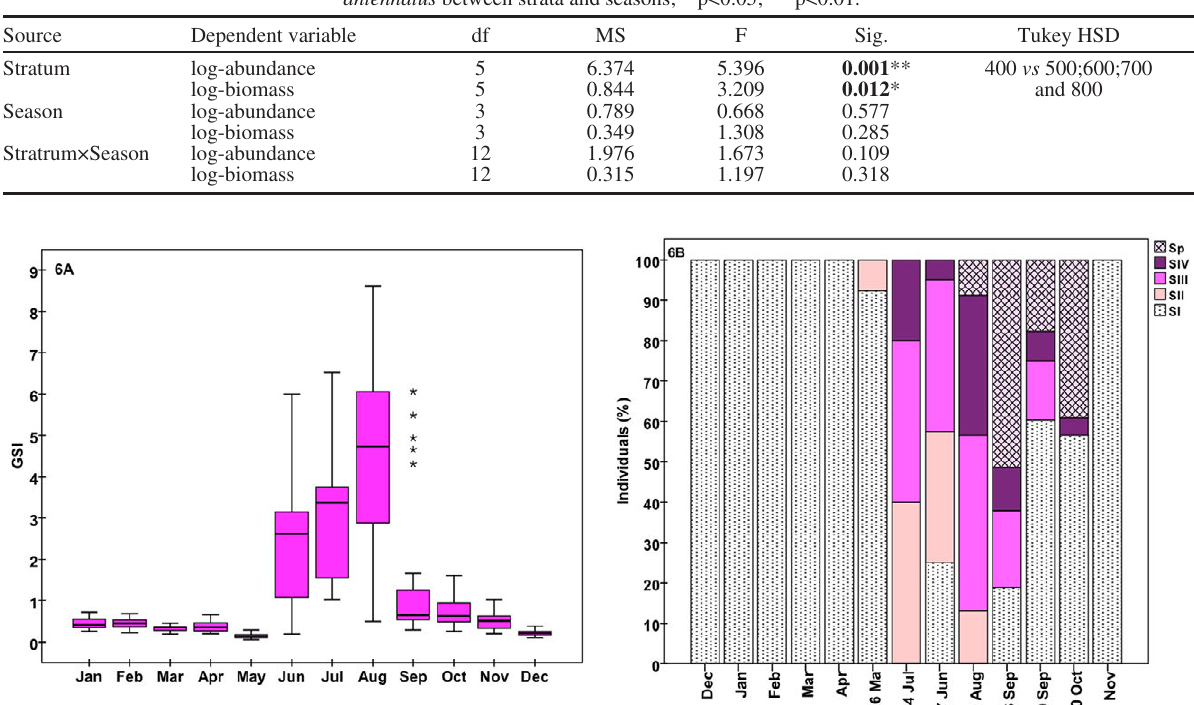
Fig. 6. – A, changes in gonadosomatic index (GSI) of standard size classes (CL ≥ 35 mm ). B, stages of gonad maturity per month of A. anten- natus females caught during surveys in Antalya